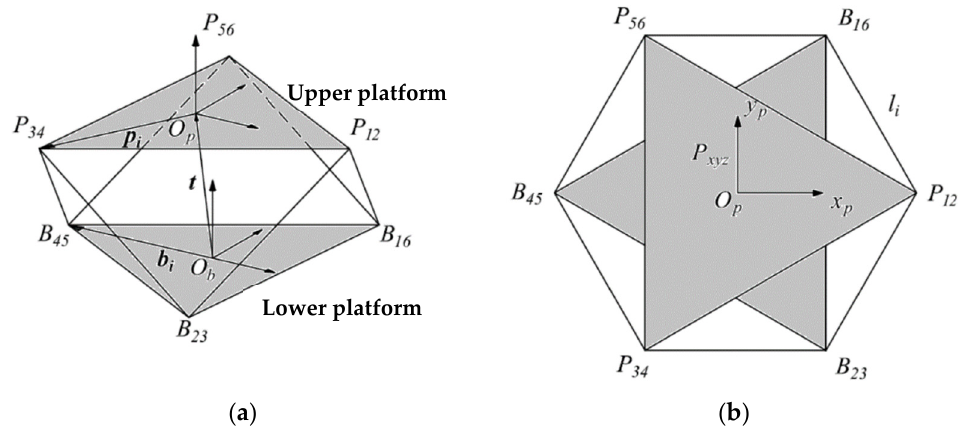
Figure 10. Vectorial representation of the cube Stewart platform. ( a ) Axonometric view of cube Stewart platform; ( b ) top view of cube Stewart platform.